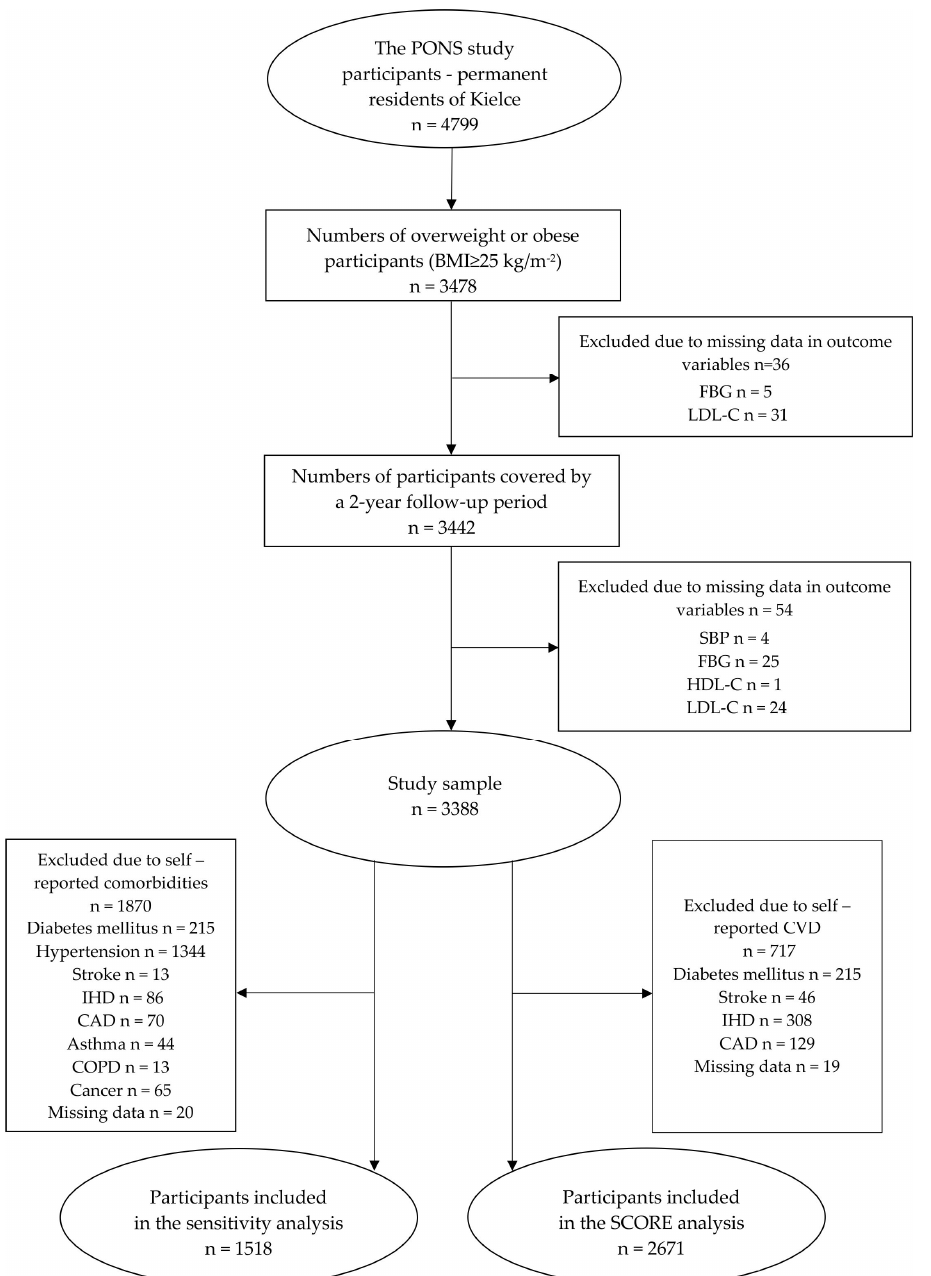
Figure 1. Data selection process in the main and the sensitivity analyses. Abbreviations: SBP, systolic blood pressure; FBG, fasting blood glucose; HDL-C, high-density lipoprotein cholesterol; LDL-C, low-density lipoprotein cholesterol; IHD, ischemic heart disease; CAD, coronary artery disease; COPD, chronic obstructive pulmonary disease; CVD, cardiovascular disease; SCORE, Systematic Coronary Risk